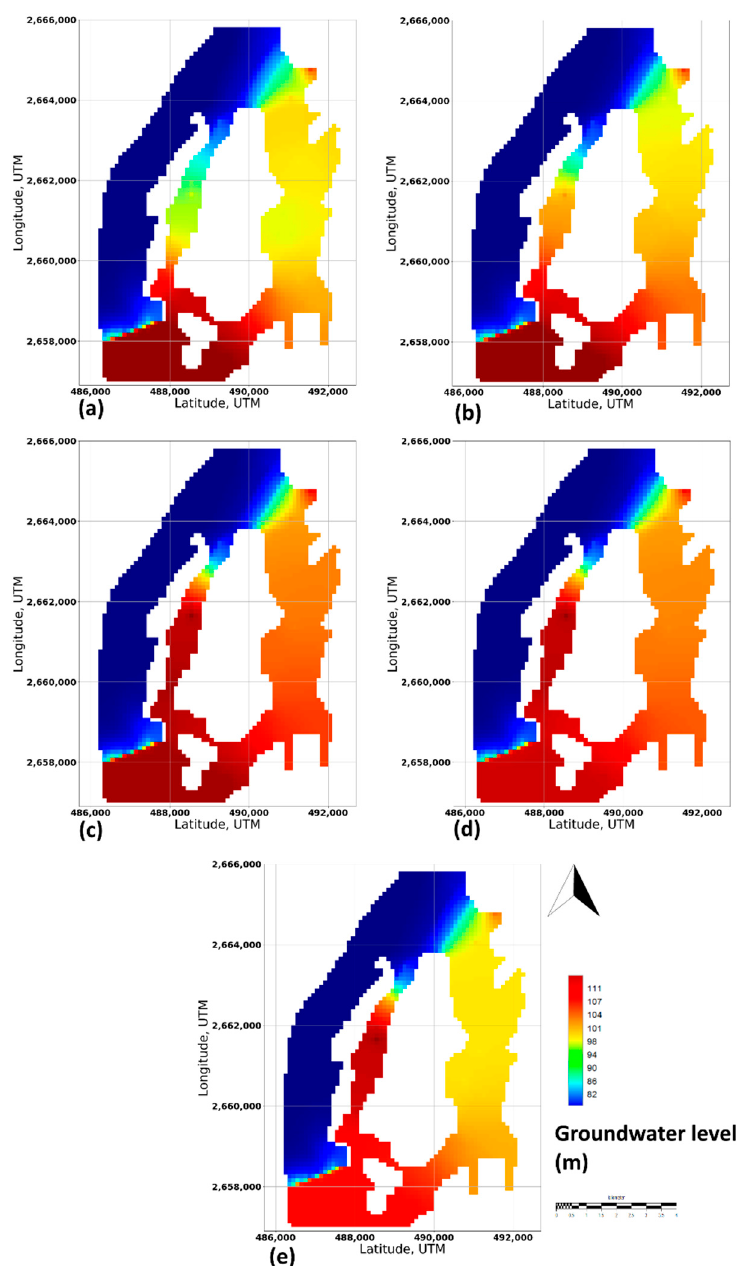
Figure 4. Simulated groundwater levels of Aswan aquifer for years ( a ) 2008, ( b ) 2009, ( c ) 2013, ( d ) 2014, and ( e ) 2017.